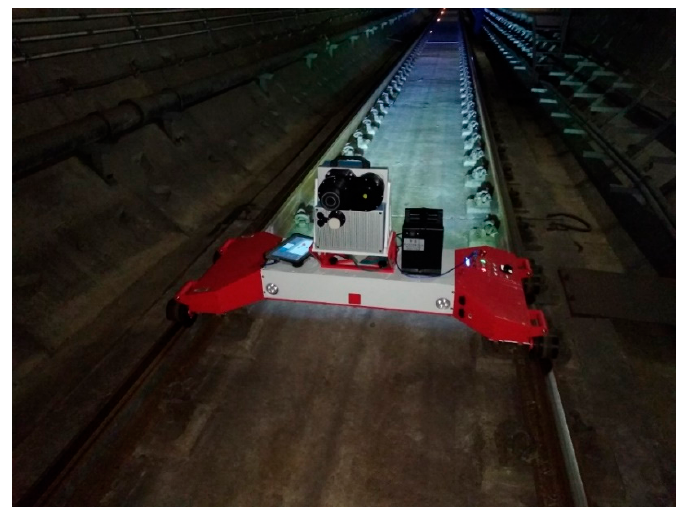
Figure 10. Tunnel scanning site.